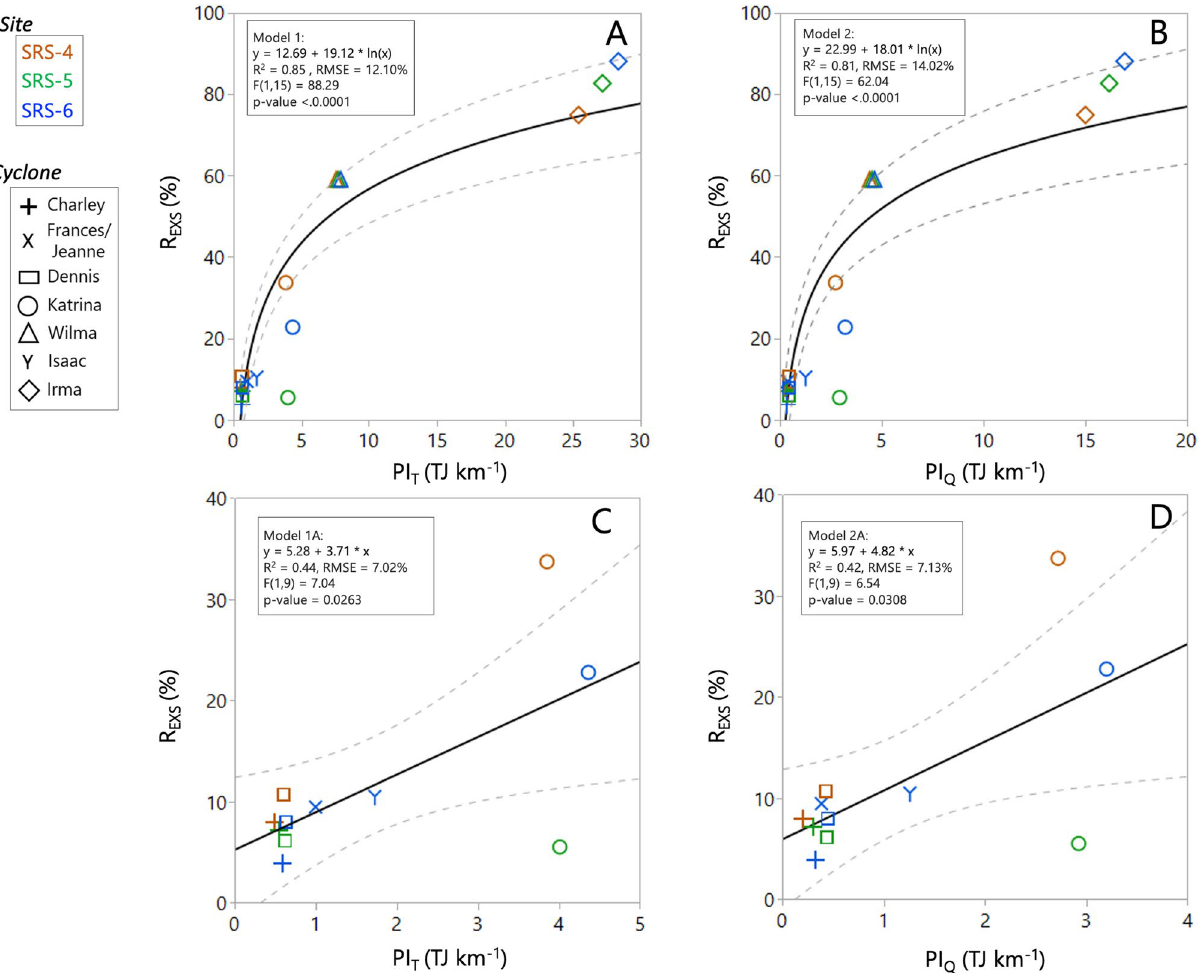
Figure 4. Non-linear and linear regressions between the R EXS and pulsing index (PI) values (PULITER Model). ( A,C) are plots between R EXS and the PI T value estimated using all the cyclone quadrants integrated kinetic energy (IKE) values (see “Methods” for details). ( B,D) show the relationship using selected quadrants IKE when estimating the PI Q value. Notice the change in the x-scale in (C,D) when strong cyclones Wilma (Category 3, 2005) and Irma (Category 3, 2017) were excluded from the regression analysis. The dashed curve indicates the 95% confidence